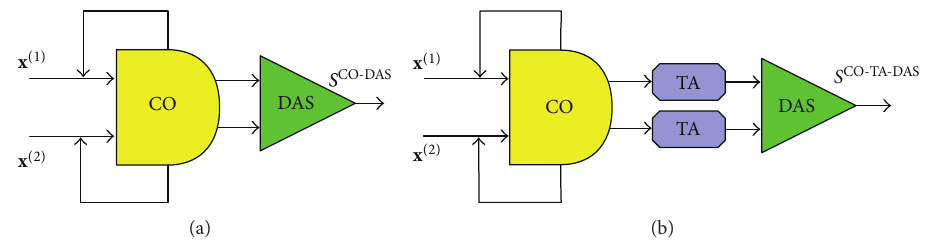
Figure 3: Co-Training with late fusion (a); Co-Training with temporal accumulation